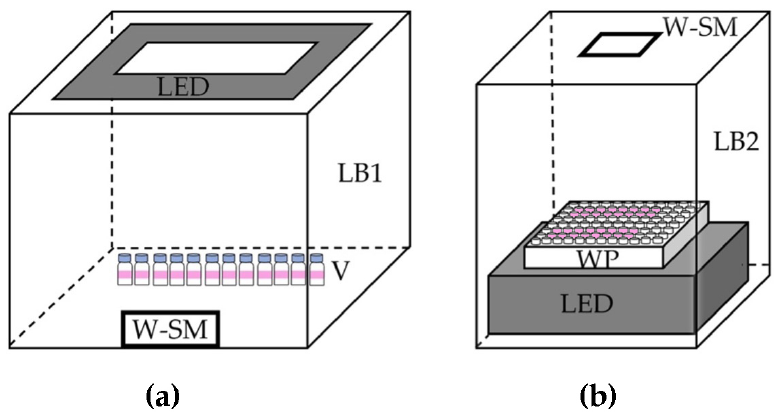
Figure 3. Illustration of the set ups for: ( a ) the extraction procedure using a small vial; ( b ) the extrac- tion procedure using a well plate. LB1 = light control box (UDIOBOX UDIO BIZ, 40 × 40 × 40 cm, Bangkok, Thailand); V = small vial; LED = light emitting diode (LED) light source; W-SM = window for smartphone, LB2 = light control box (15 × 11 × 25 cm); LED = LED light source (LD-160, 14 × 5.7 × 9.5 cm, Lightdow, Shenzhen, China); WP = well plate; W-SM = window for smartphone. Note: the dimensions are not to scale.